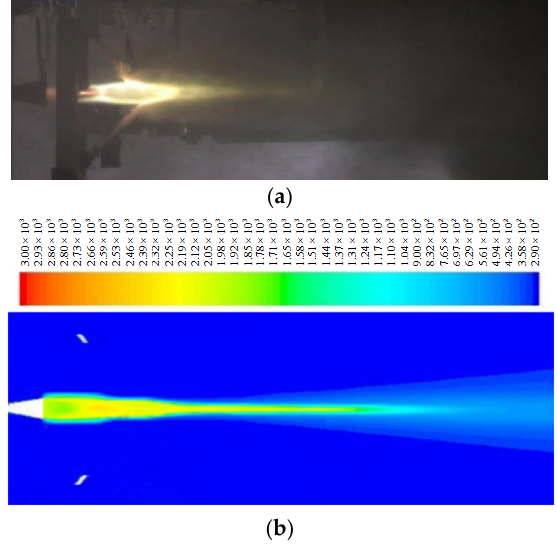
Figure 11. ( a ) Experimental jet with water injection; ( b ) Temperature contour with water injection.